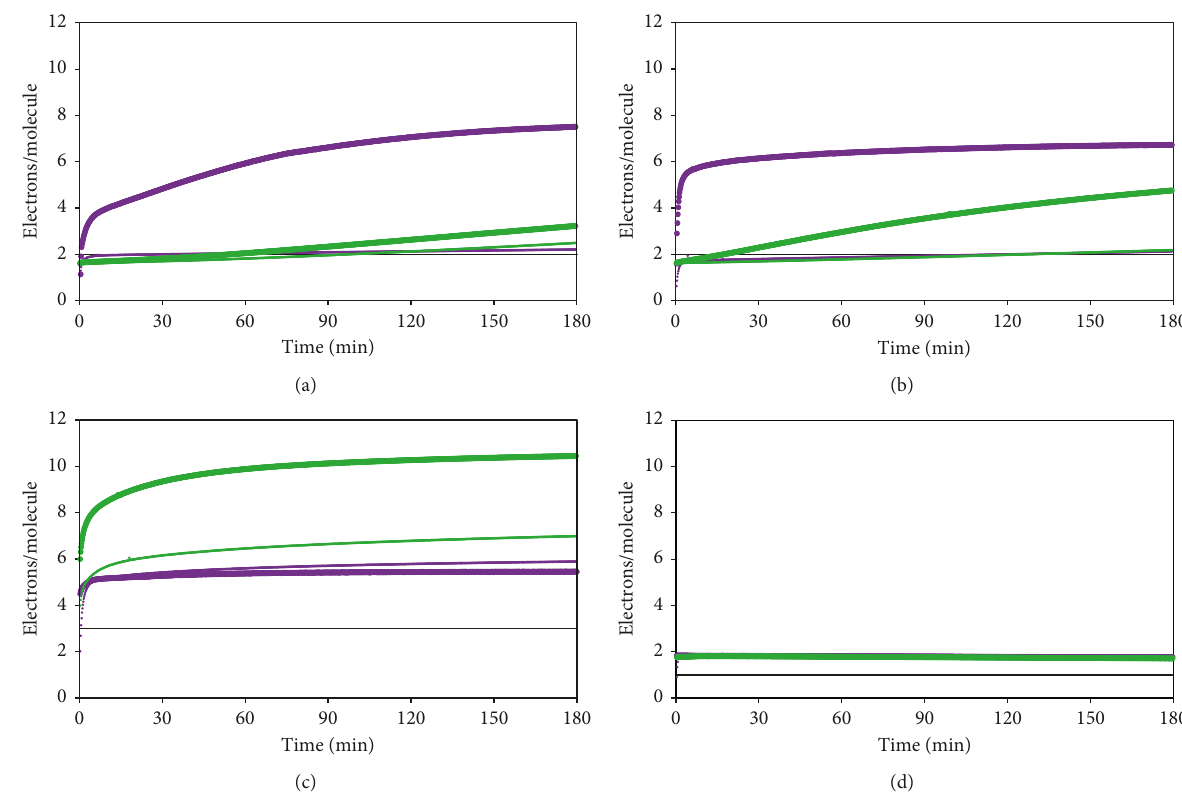
Figure 2: The number of exchanged electrons per molecule as a function of incubation time at 25 ° C for caffeic acid (CA), chlorogenic acid (CGA), gallic acid (GA), and Trolox in DPPH assay in methanol (thin purple) or DPPH assay in the mixture of methanol and buffer (pH 7.4) (thick purple) and ABTS assays in MilliQ water (thin green) or buffer (pH 7.4) (thick green). Black lines correspond to the number of OH groups in the molecule. (a) Caffeic acid (CA), (b) chlorogenic acid (CGA), (c) gallic acid (GA), (d)